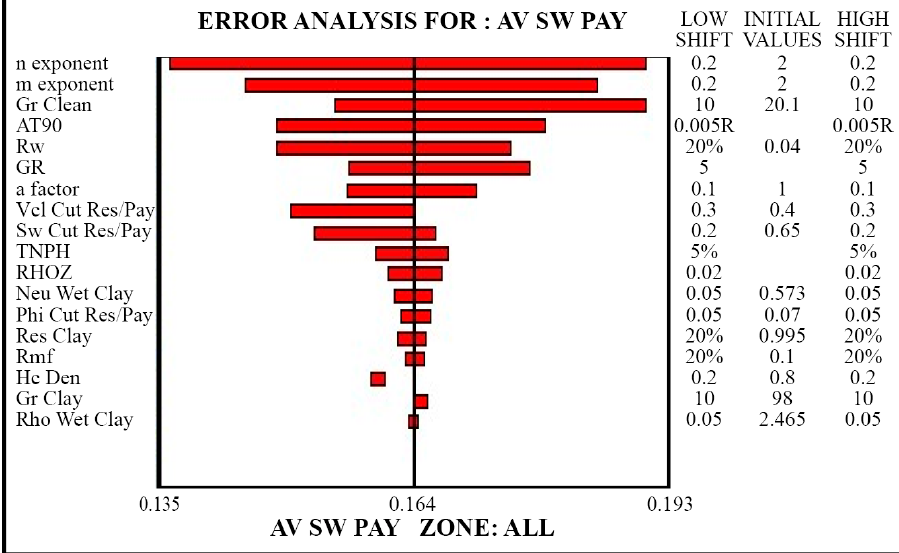
Figure 4. A Tornado plot for average S w calculations in well ND-1.